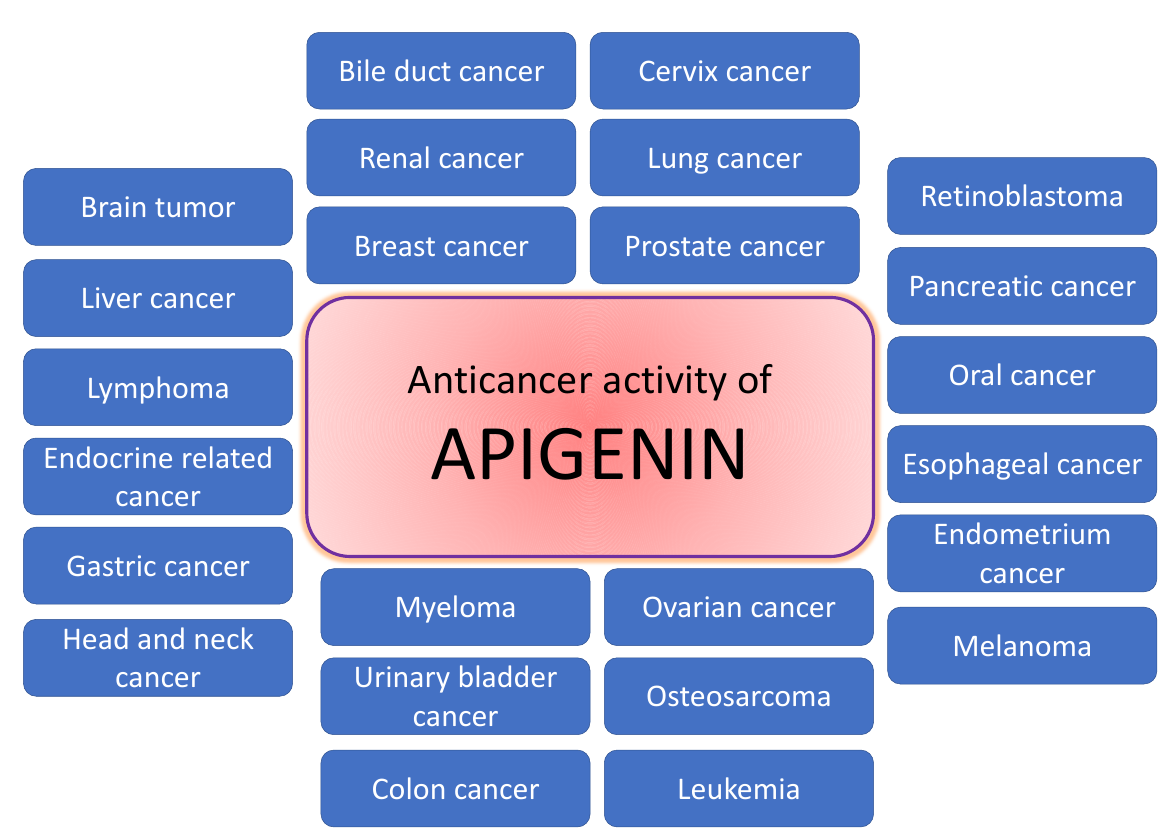
Figure 3. Anti-cancer activity of apigenin: Apigenin plays a significant role in cancer inhibition through inhibiting the carcinogenesis by many various molecular interactions and processes, such as the regulation of the apoptotic machinery, aberrant cell signaling and oncogenic protein network.